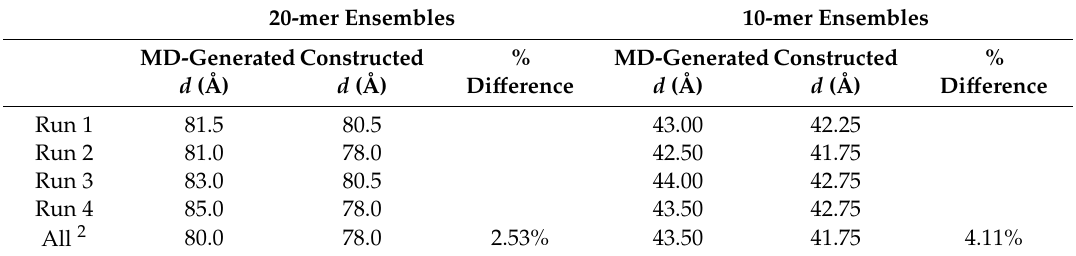
Figure 2. End-to-end distance probability distribution of MD-generated hyaluronan 20-mer ensemble; each of the four runs includes 10,000 conformations; probabilities were calculated for end-to-end distances sorted into 0.5 Å bins. Table 1. Most Probable End-to-End Distances ( d ) in MD-Generated and Constructed Hyaluronan Ensembles 1 .